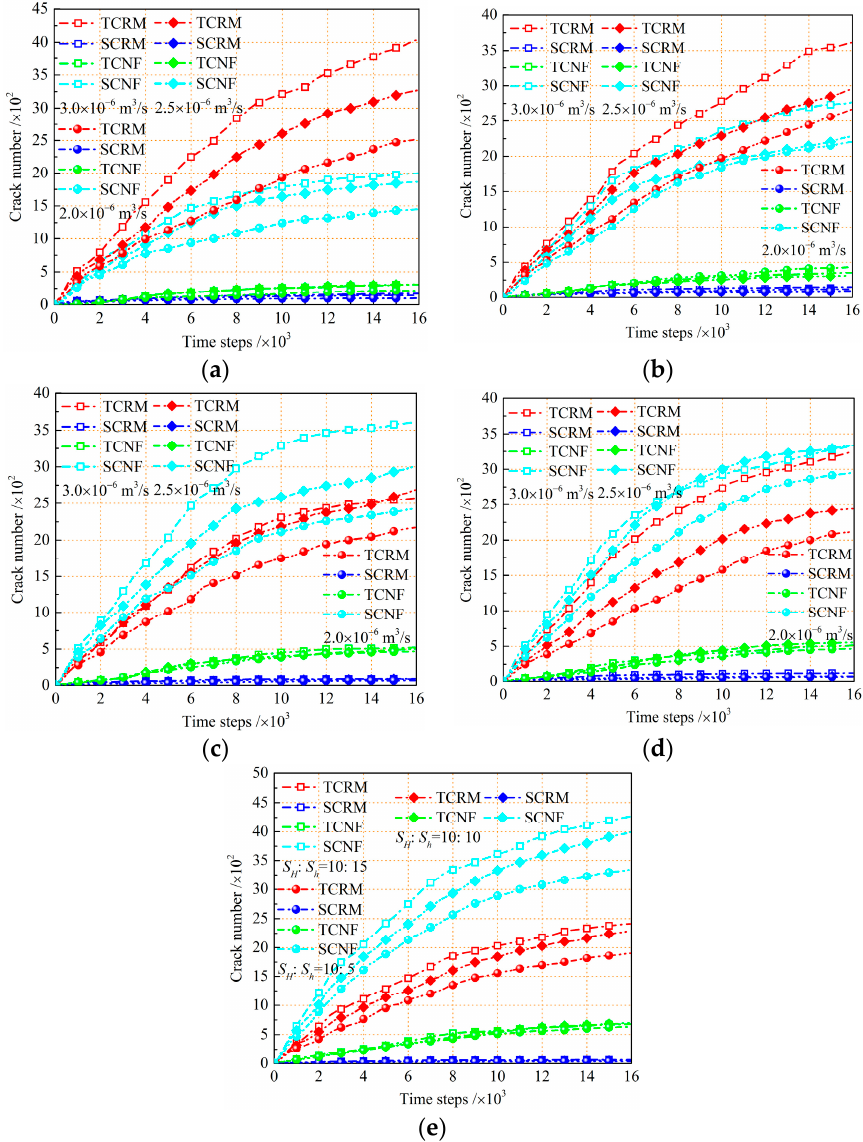
Figure 28. Incremental accumulation of TCRM, SCRM, TCNF, and SCNF in various NF densities when the confining pressure ratio is S H : S h = 10:5; ( a ) ρ = 24/m; ( b ) ρ = 36/m; ( c ) ρ = 48/m; ( d ) ρ = 60/m; and ( e ) ρ =